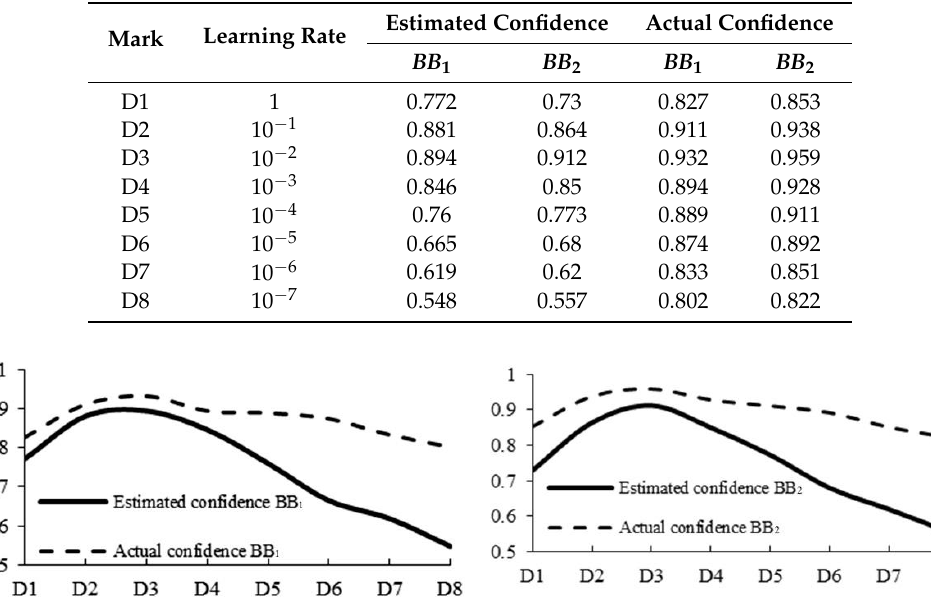
Table 3. Model performance under different learning rates.